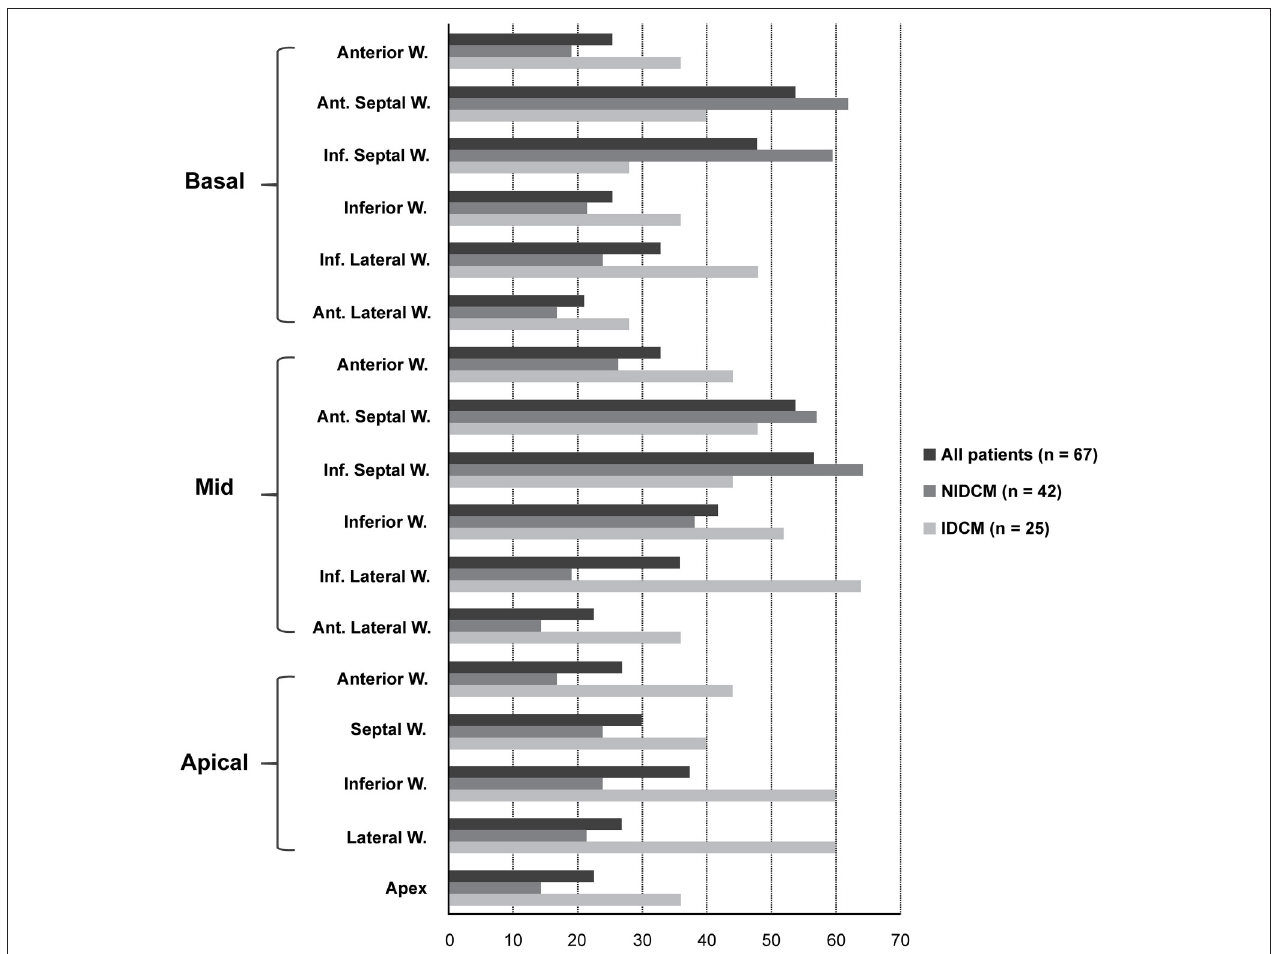
FIGURE 2 | The distribution of LGE in individual myocardial segments in all LGE positive patients (blue bars), in patients with IDCM (green bars), and in patients with NIDCM (red bars). The diagram demonstrates that LGE in patients with NIDCM occurs most commonly in the septal wall of the left ventricle while LGE in patients with IDCM commonly involves the coronary artery dominated area. IDCM, ischemia-dilated cardiomyopathy; LGE, late gadolinium enhancement; NICD, non-ischemia-dilated